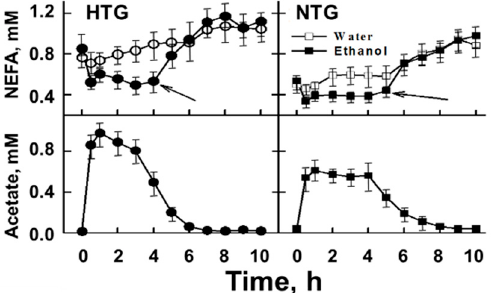
Figure 3. Plasma NEFA and acetate levels vs. time among HTG and NTG. Values are mean ± standard error of the mean (SEM). In both groups, the acetate concentration at which lipolysis recovers, according to increasing non-esterified fatty acid (NEFA) concentration, is ~0.2 mM acetate. With permission